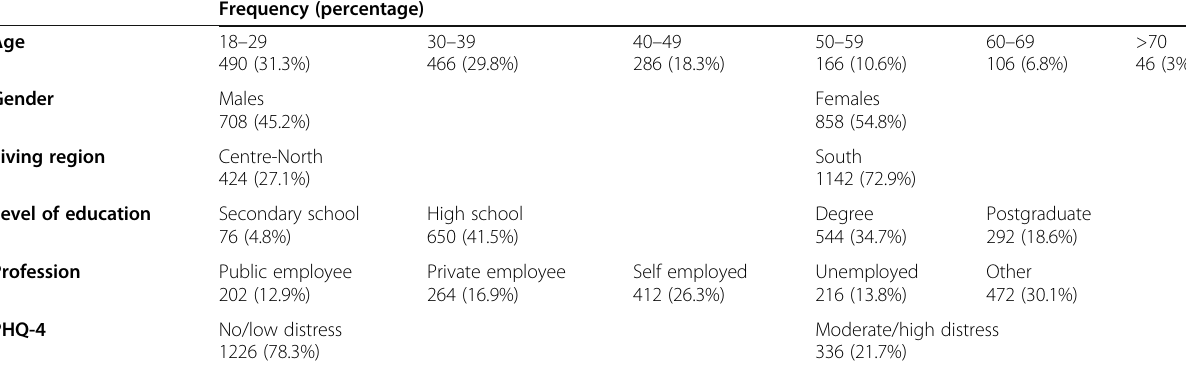
Table 1 General data of the participants